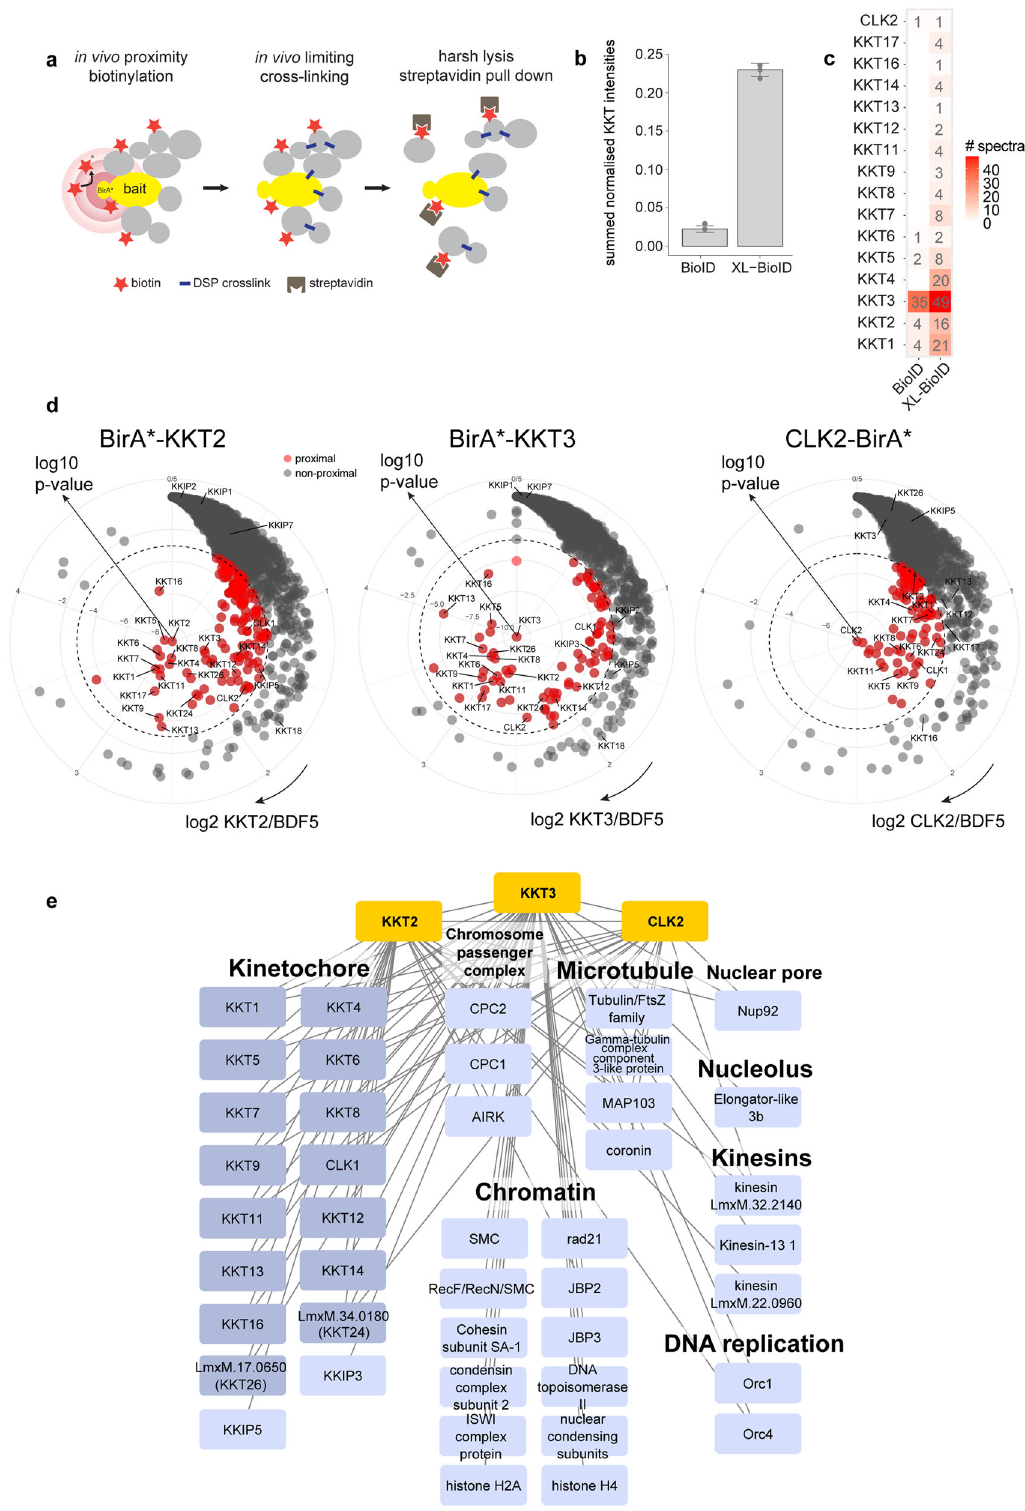
reference 10 . From the three baits, a total of 229 high-con fi dence proximal proteins were identi fi ed at 1% FDR (Fig. 1d and Sup- plementary Data 2, 3). KKT2 and KKT3 were associated with 149 and 79 proximal proteins, respectively, CLK2 was proximal to 88 proteins. Proximity maps of enriched proteins are similar for KKT2 and KKT3, but the proximity map for CLK2 shows a weaker enrichment for kinetochore subunits (Fig. 1d), KKT2 and